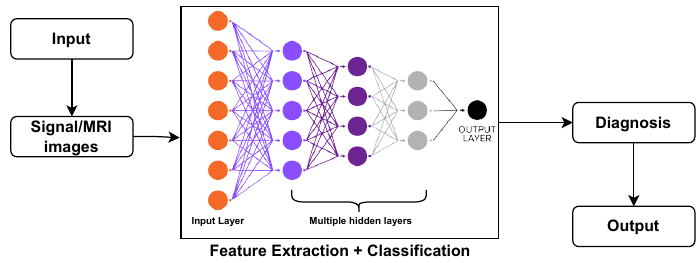
Figure 4. Representation of common deep neural network